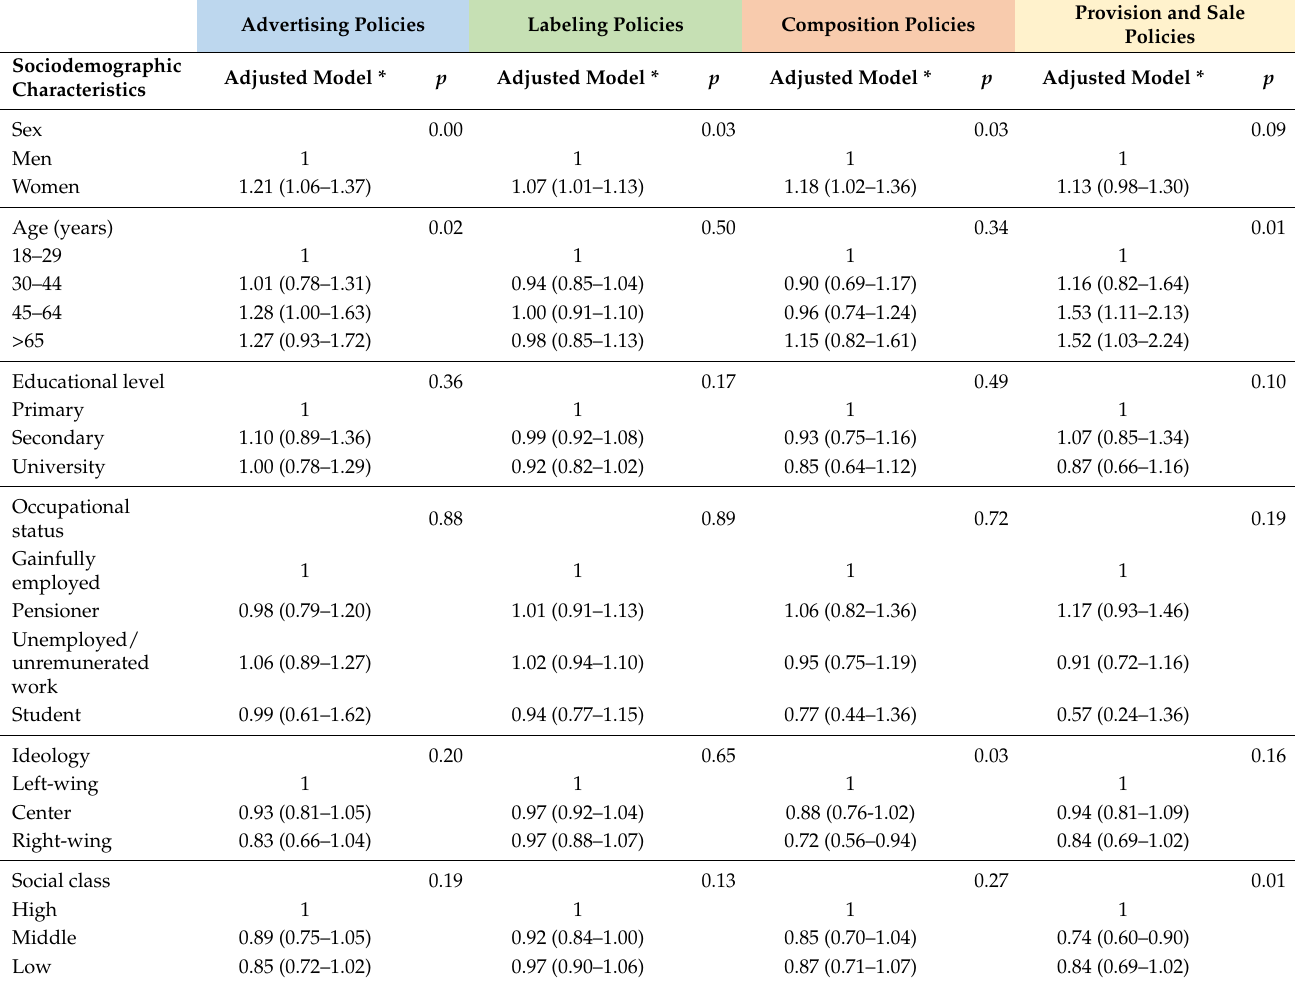
Table 3. Prevalence ratios (95% CI) of support for food policies, yielded with Poisson regression